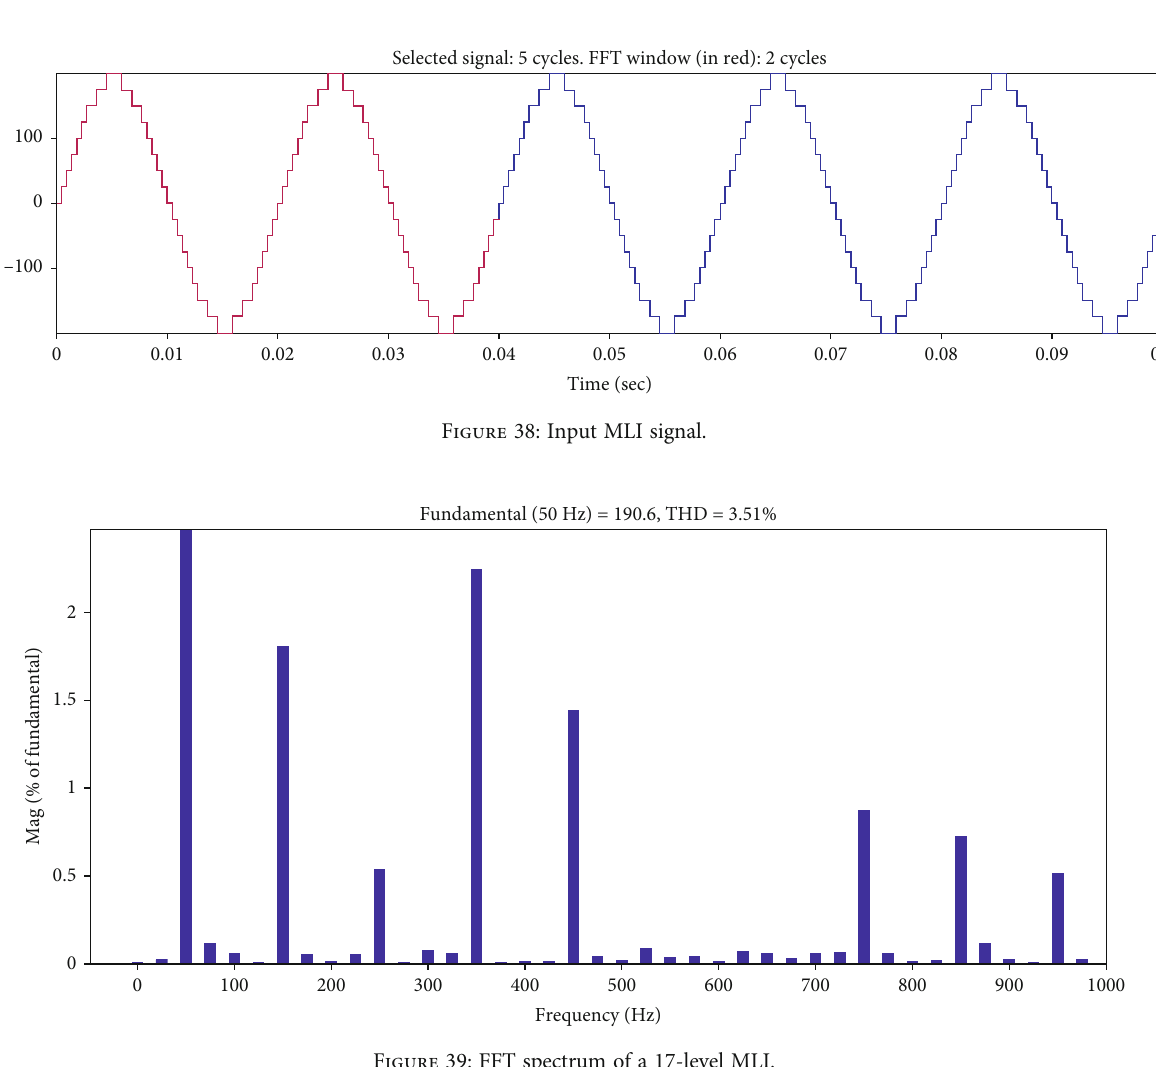
Figure 39: FFT spectrum of a 17-level